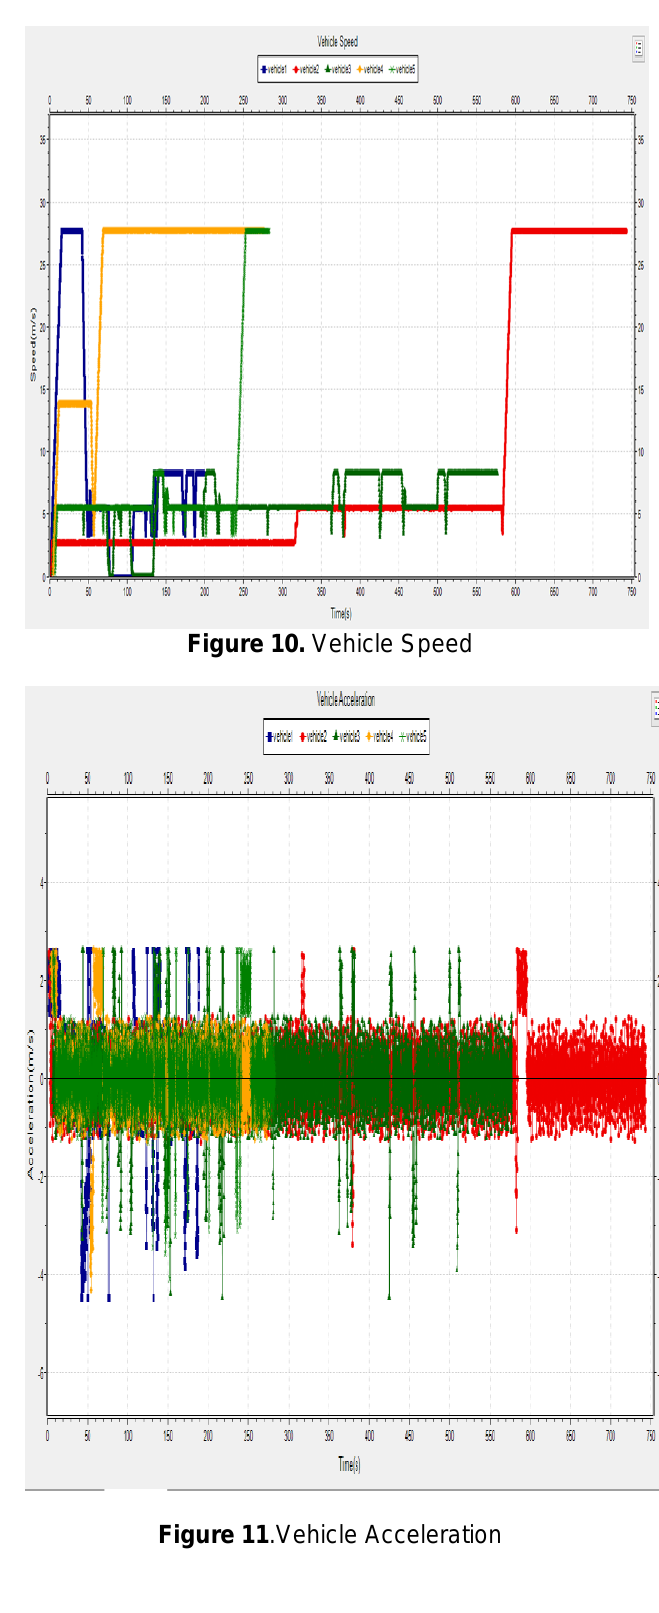
Figure 11 .Vehicle